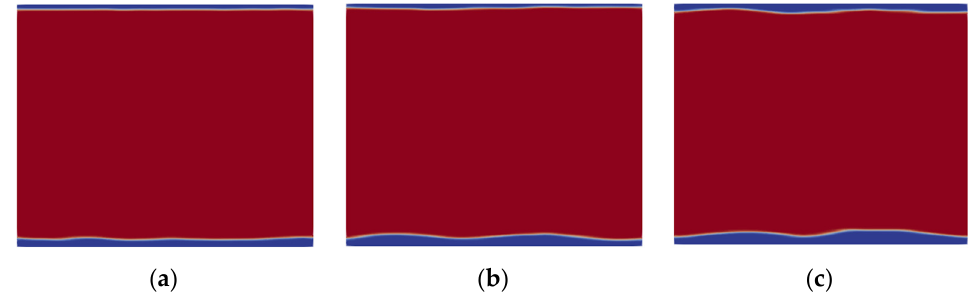
Figure 4. Oil–water core–annular flow in horizontal pipe (( a ) ε w = 0.0877; ( b ) ε w = 0.0954; ( c ) ε w = 0.1203; red is oil, blue is water, which means the same later).